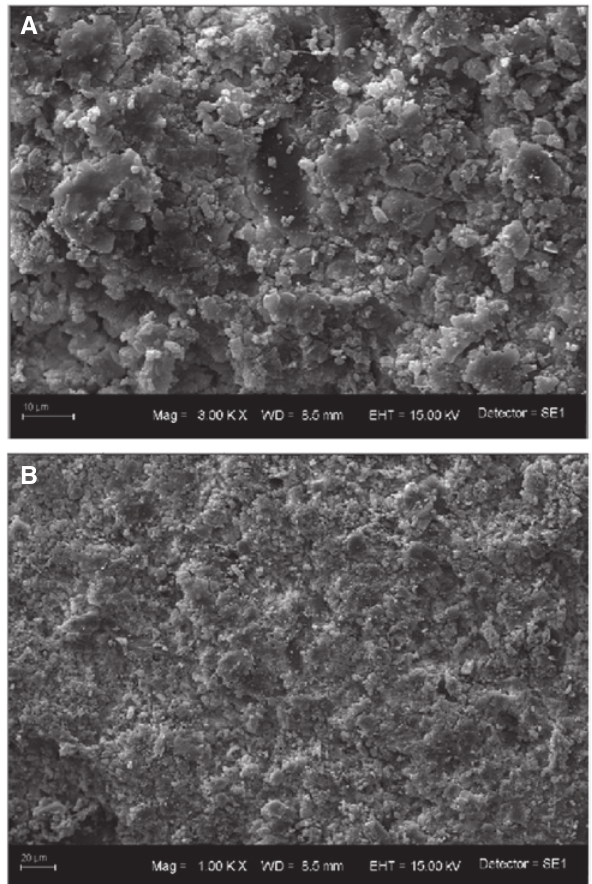
Figure 1 (A) 10 wt% of walnut particles. (B) 25 wt% of walnut